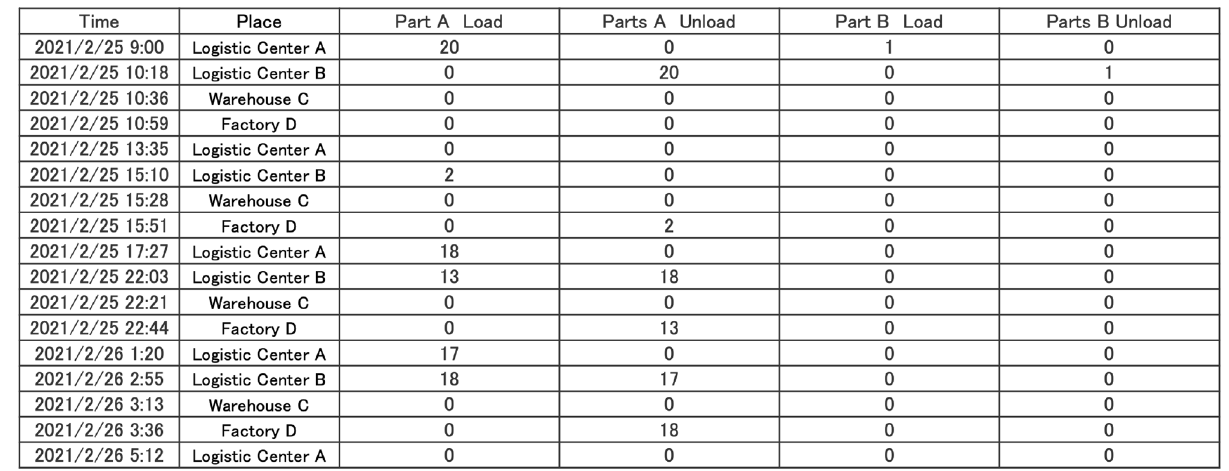
Figure 8. Example of a detailed route found for a truck after D-Wave hybrid execution followed by full-scale simulation. This table only includes loading and unloading instructions for two of approximately 15, 000 parts, all of which are accounted for in our